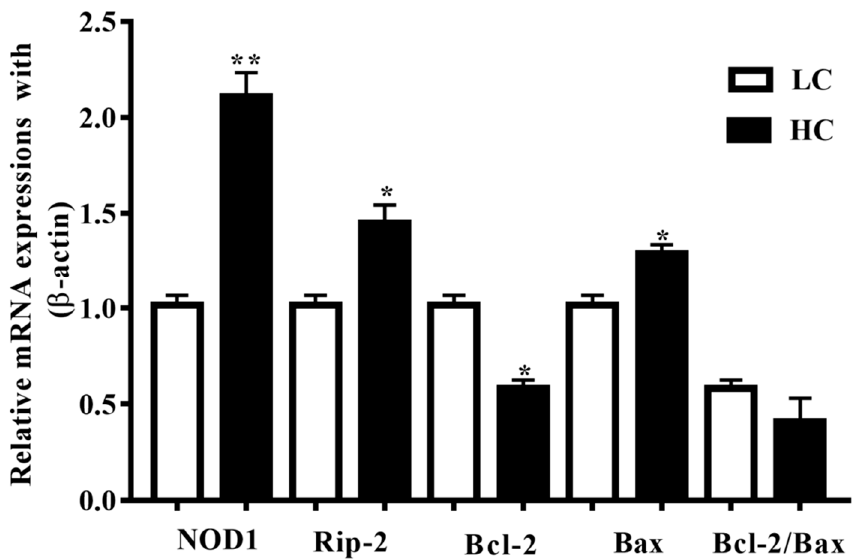
Figure 2. Relative mRNA expressions of NOD1, Rip-2, Bax, and Bcl-2 in comparison with the β -actin universal control. NOD1 and Rip-2, and Bax mRNA expressions in the mammary gland tissue were higher in the HC group than in the LC group. Conversely, the Bcl-2 mRNA expressions were markedly lower in the HC group than in the LC group. * p < 0.05 and ** p < 0.01 versus control.